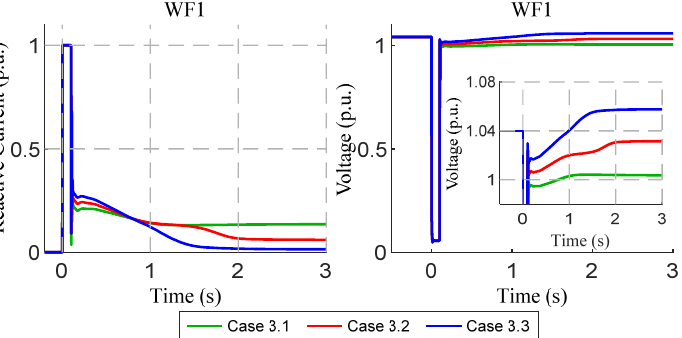
Figure 22. WF1 reactive current output and terminal voltage following different voltage/reactive current hysteresis tuning.